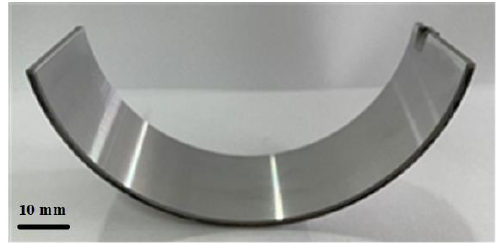
Figure 3. Sliding bearing.